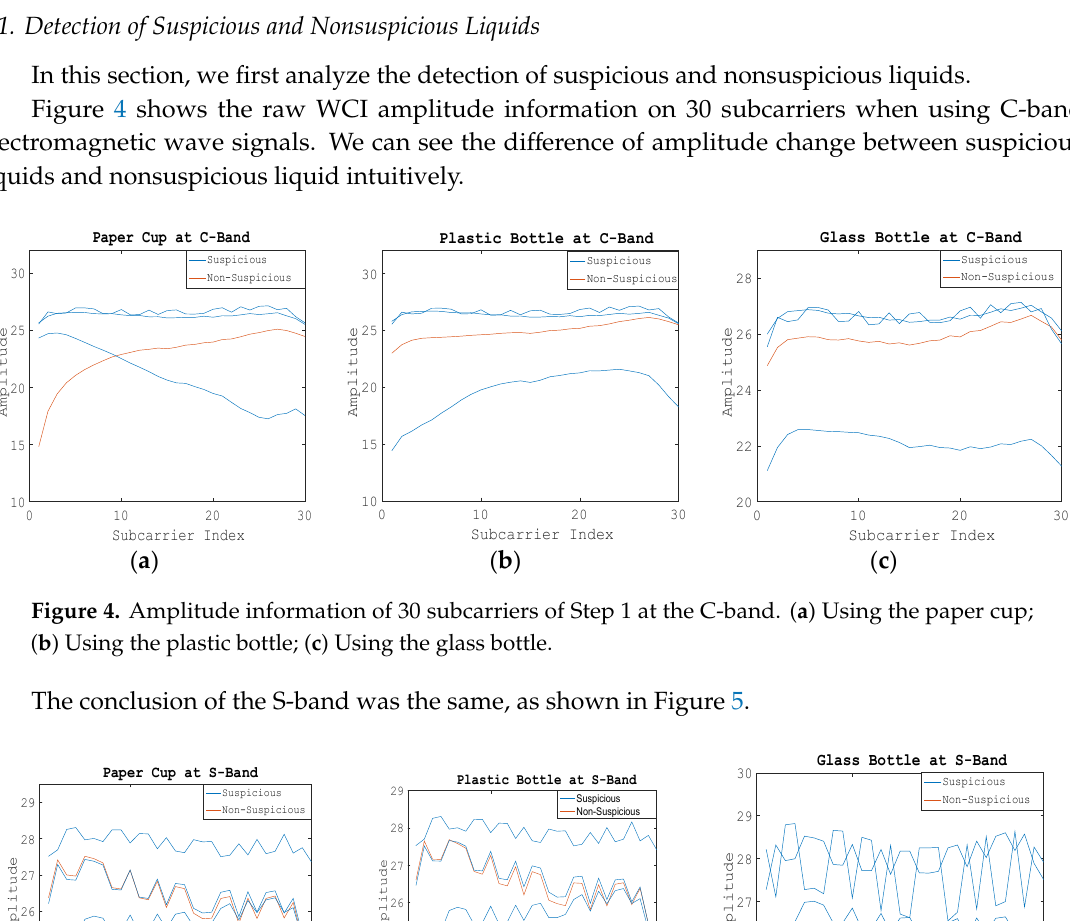
Figure 5. Amplitude information of 30 subcarriers of Step 1 at the S-band. ( a ) Using the paper cup; ( b ) Using the plastic bottle; ( c ) Using the glass bottle.